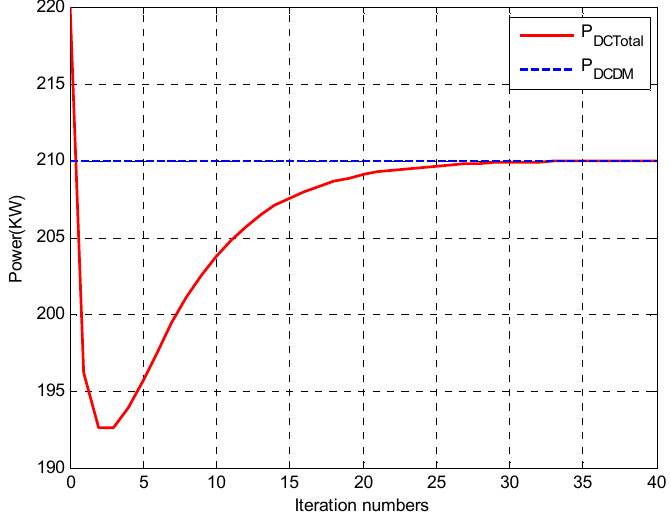
Figure 6. Power mismatch of a single period in the AC sub-grid.